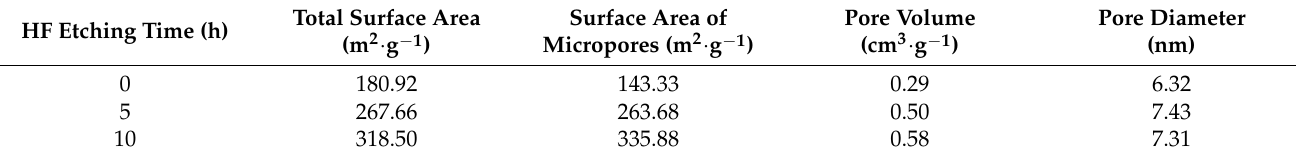
Figure 1. Schematic illustration of the synthesis process for S-C.